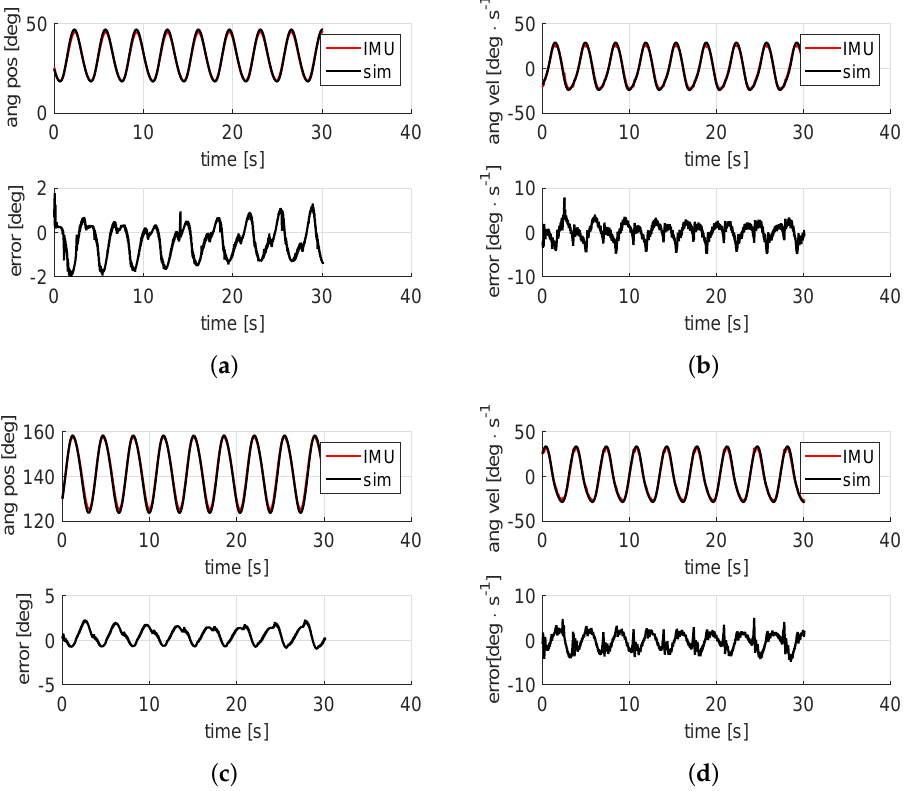
Figure 5. Some results from the experimental validation. In all plots, real data from sensors are superposed over the results from kinematics-based estimations. The left-hand figures show the angular positions of the coupler and rocker links and their estimation errors, whereas their corresponding angular velocities are shown in the right-hand plots. ( a ) Coupler link angular position; ( b ) Coupler link angular velocity; ( c ) Rocker link angular position; ( d ) Rocker link angular